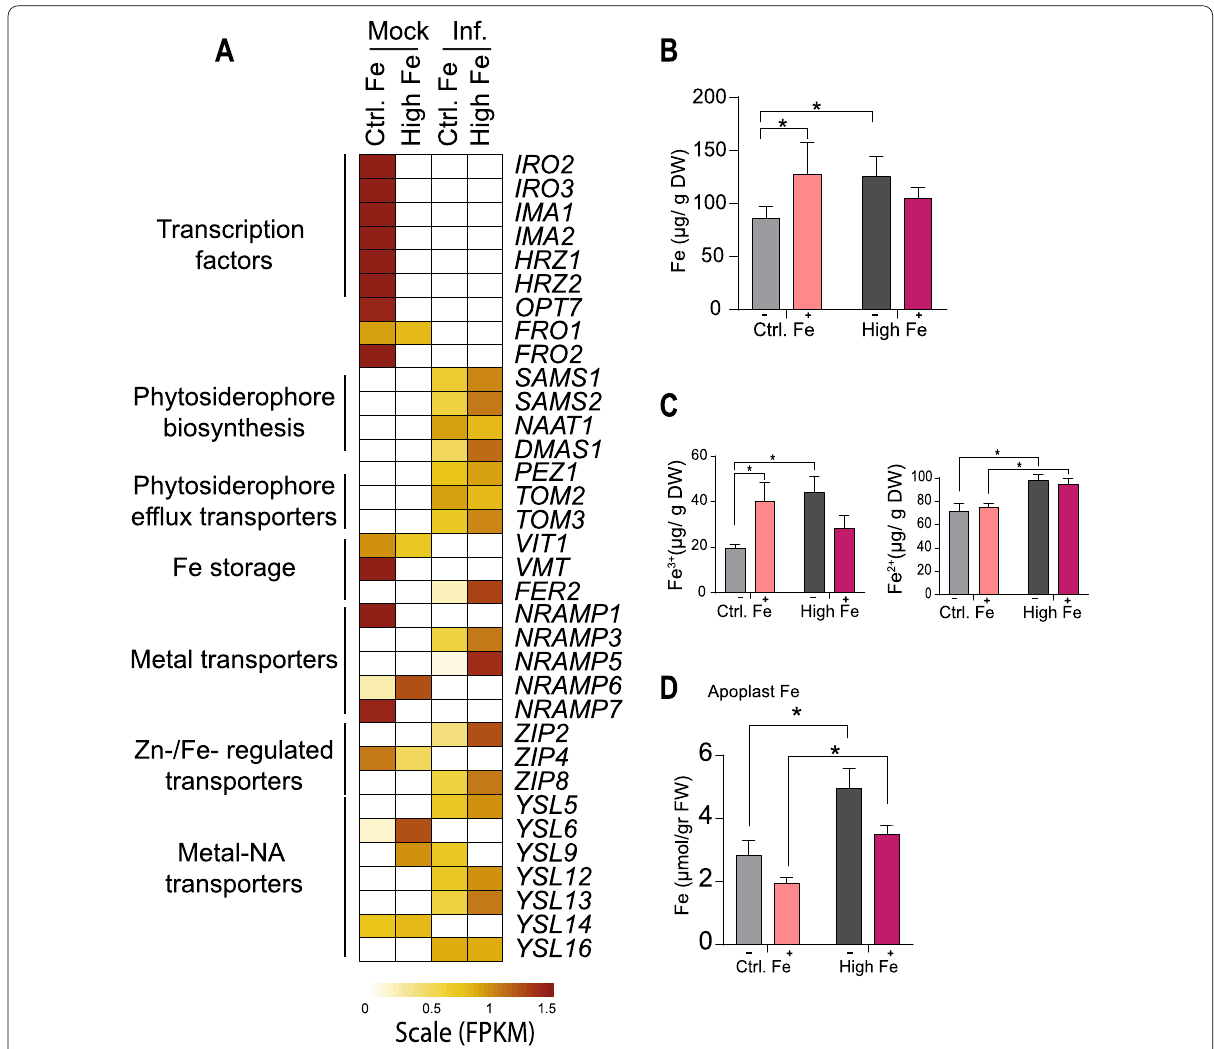
Fig. 7 Effect of pathogen infection on Fe homeostasis‑related genes and pathogen‑induced alterations on Fe content in leaves. A Heat map showing the expression level of iron‑related genes (row scaled FPKMs) in leaves of Control and High‑Fe plants (mock‑inoculated and M. oryzae ‑inoculated) at 48 hpi. Gene expression is represented from pale yellow (less expressed) to brown (more expressed). The full name and details on the expression of these genes are indicated in Additional file 7: Table S6. B Total Fe content in the youngest developed leaf (third leaf) ( mock‑inoculated; , M. oryzae ‑inoculated). Five independent biological replicates (three technical replicate each) were analyzed. C Fe 2 + and Fe 3 + + content was determined by the colorimetric Ferrozine method in the youngest developed leaf of Control and High‑Fe plants. D Fe content in the apoplast of leaves (youngest developed leaves) determined by ICP‑MS. Five independent biological replicates (three technical replicate each) were analyzed. Data are mean SEM. Asterisks indicate statistically significant differences calculated by two‑way ANOVA *, P ± fresh